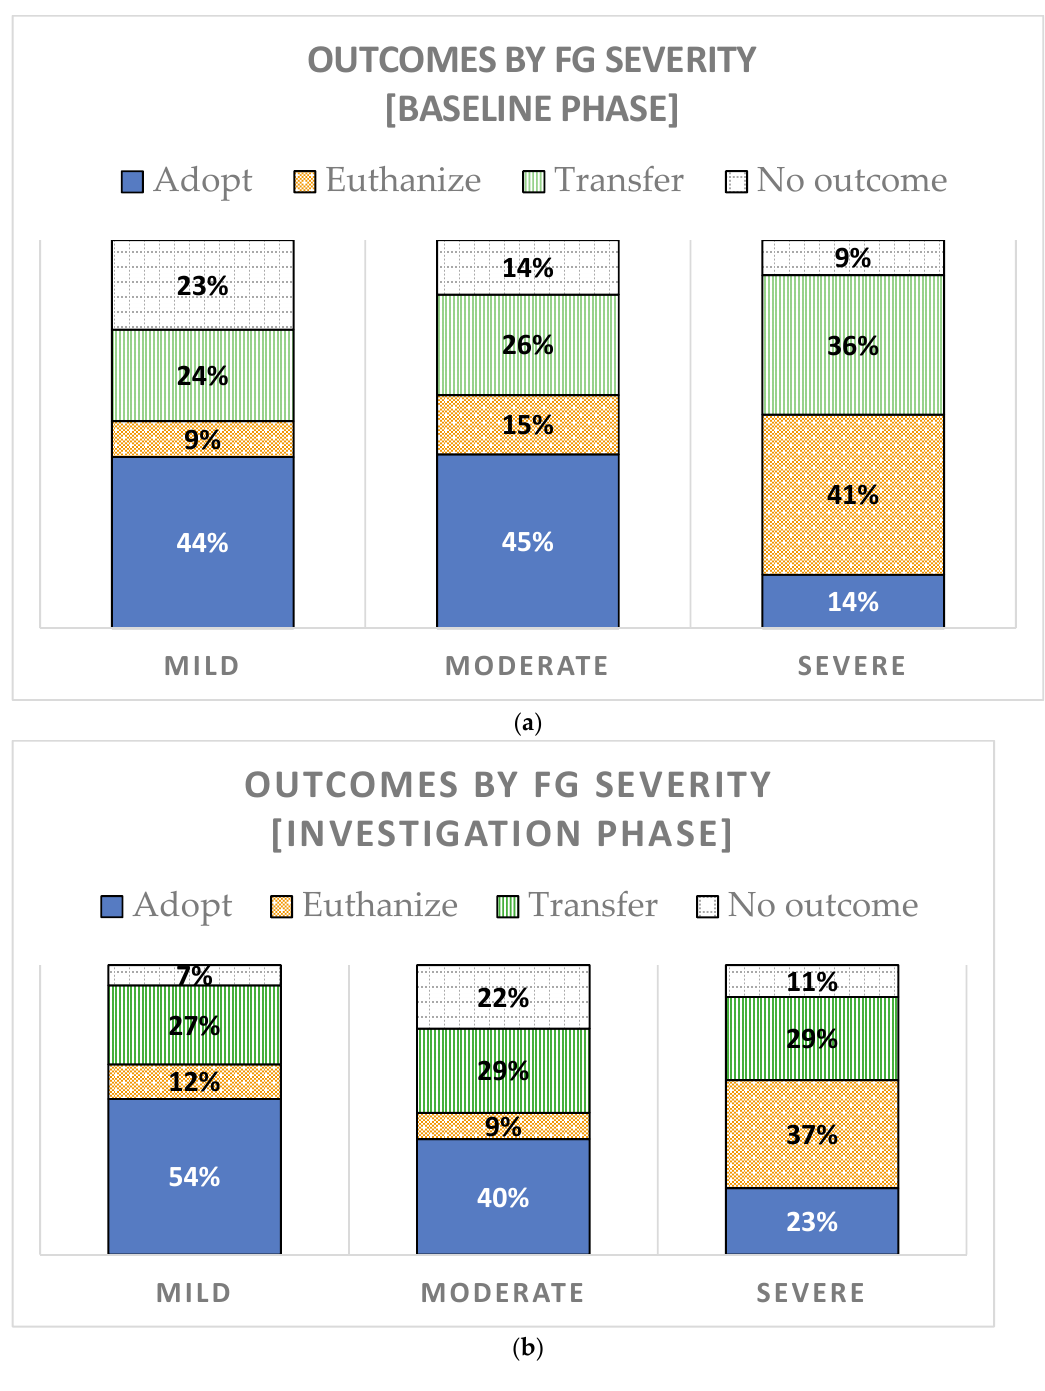
Figure 2 . Outcomes of the FG dogs, by severity of FG behavior, are shown for the ( a ) Baseline phase ( b ) Investigation phase. Some dogs in each severity category did not have an outcome by the end of the study period (no outcome). In the baseline, 20% of FG was identified by history and 80% by the assessment. During the investigation phase, 71% of FG was identified by history and 29% from shelter observations.